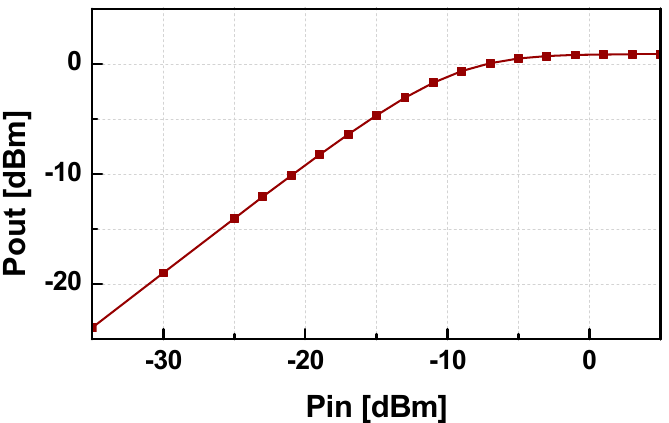
Figure 14. Simulated output power versus input power of the amplifier at 283 GHz.